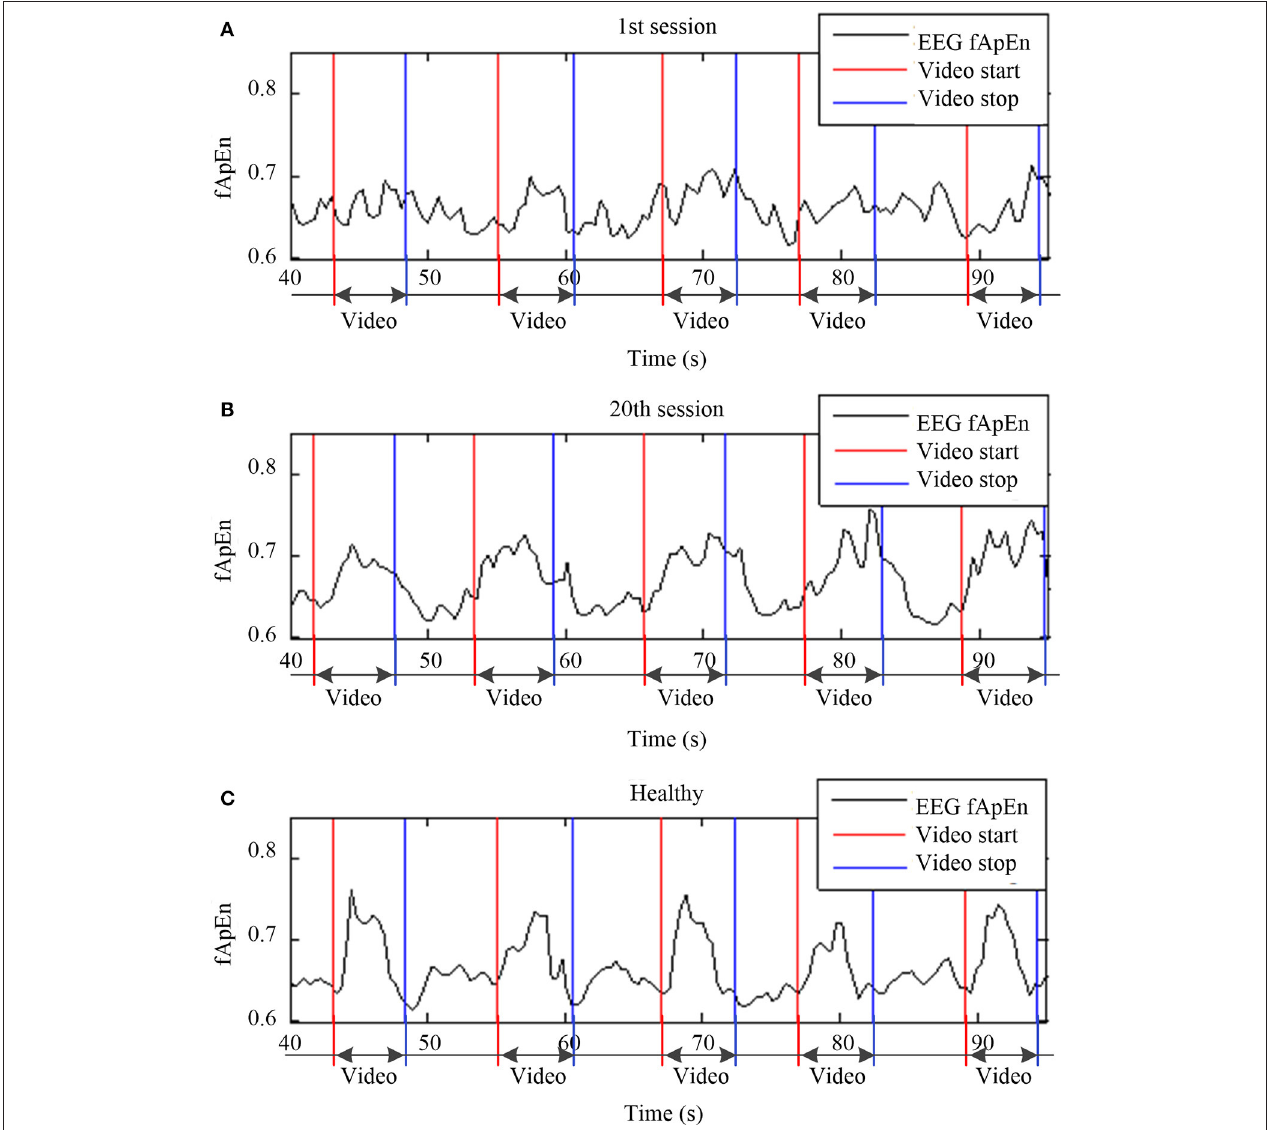
FIGURE 5 | Sliding window of EEG fApEn during the (A) first training session, (B) and 20th training session from a stroke participant (S3) and a healthy participant (C)